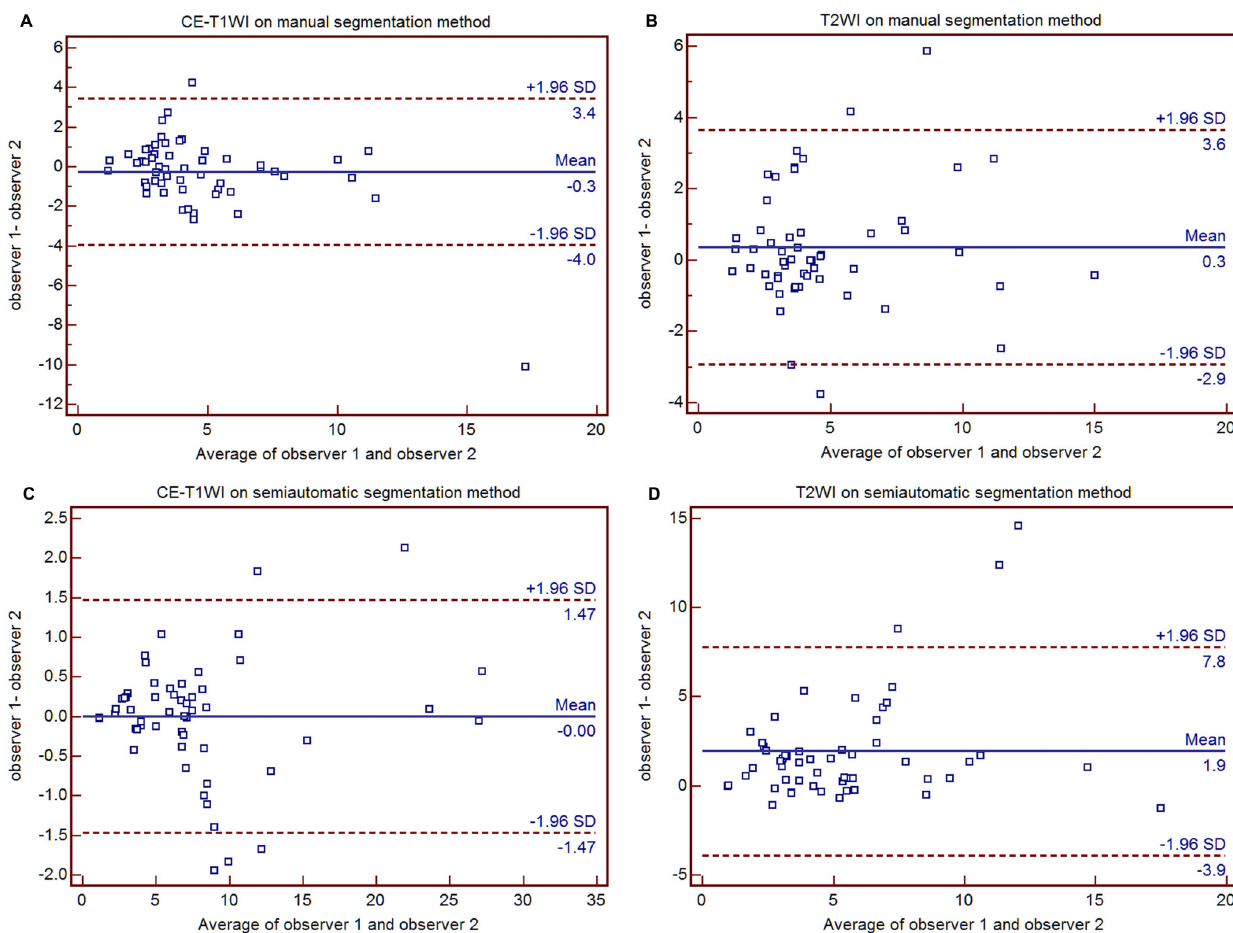
Figure 4. Bland-Altman plots show interobserver reproducibility according to structural imaging technique for both CE-T1WI (a) and T2WI (b) with the manual method and CE-T1WI (c) and T2WI (d) with the semiautomatic segmentation method. Interobserver reproducibility using the semiautomatic segmentation method was better than with the manual method for CE-T1WI-based evaluation and lower than with the manual method for T2WI-based evaluation. CE-T1WI=contrast enhanced T1-weighted imaging; T2WI=T2-weighted imaging.